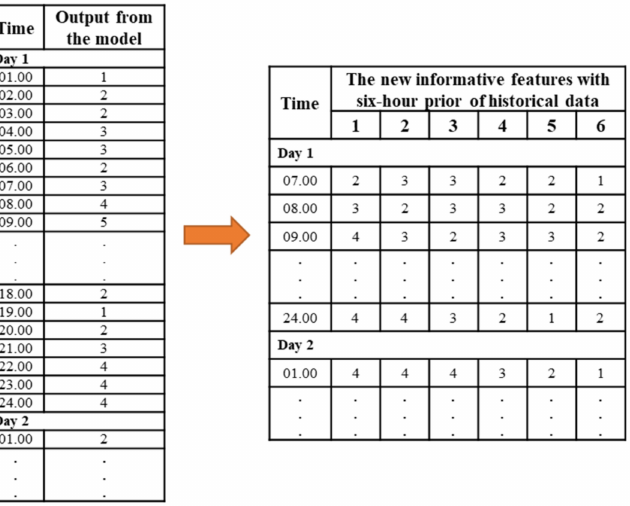
Figure 4. Example of new informative features with six-hour prior data created from the NFT-MEP